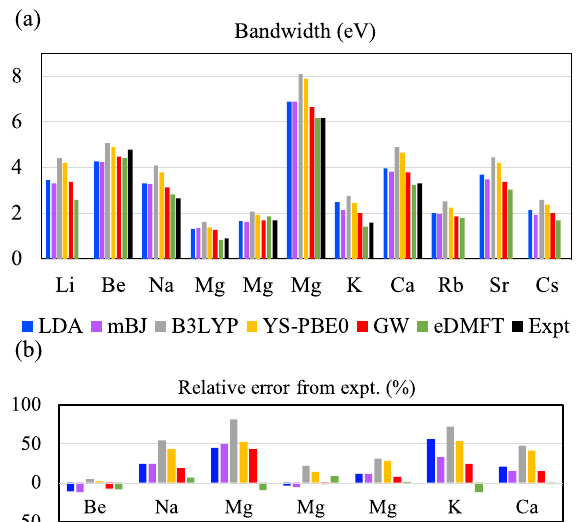
Fig. 4 Comparison of bandwidths for alkali and alkaline-earth metals. a bandwidth values (in eV) as obtained from various beyond-DFT approaches and ( b ) their relative error from the